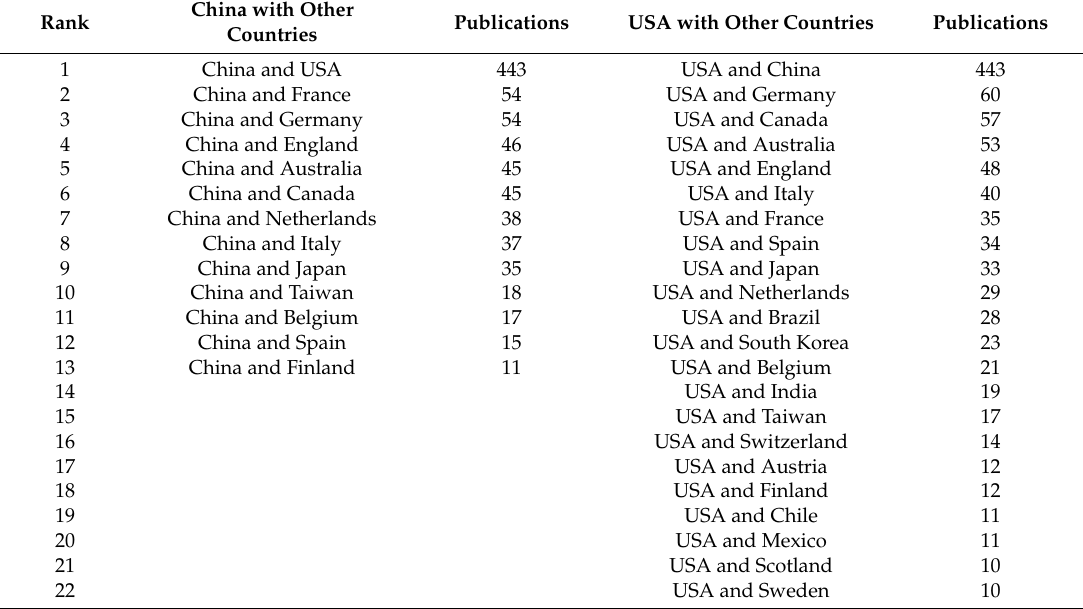
Table 9. The number of publications for cooperation among China/USA with other countries (the number of cooperation publications exceeds